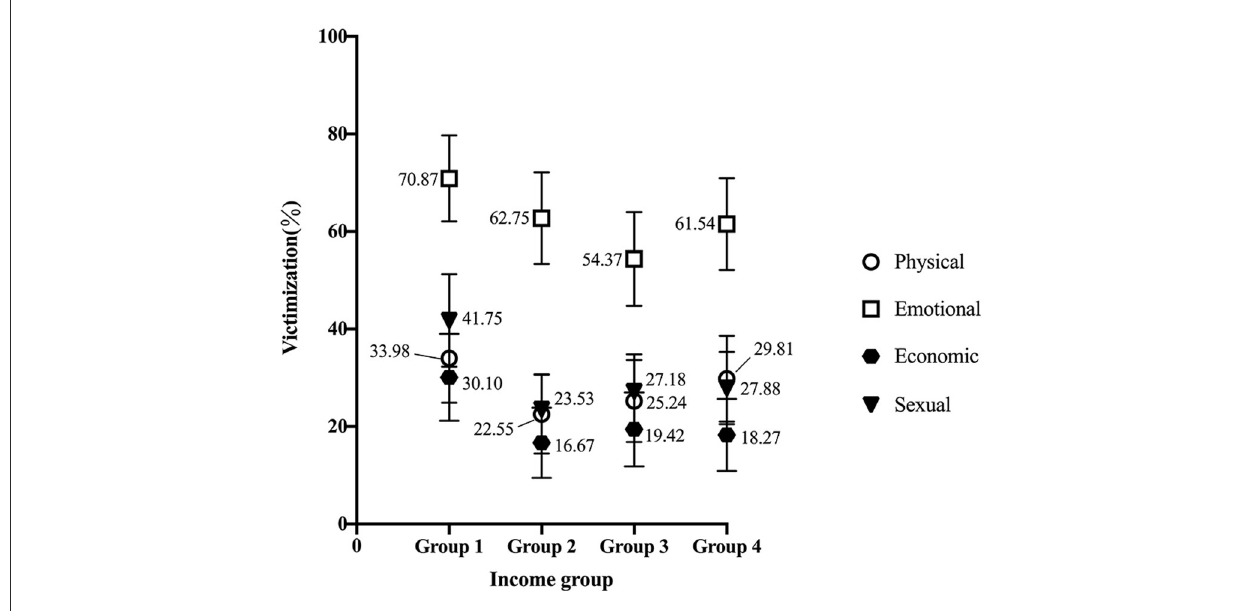
FIGURE1 Results of domestic violence victimization.